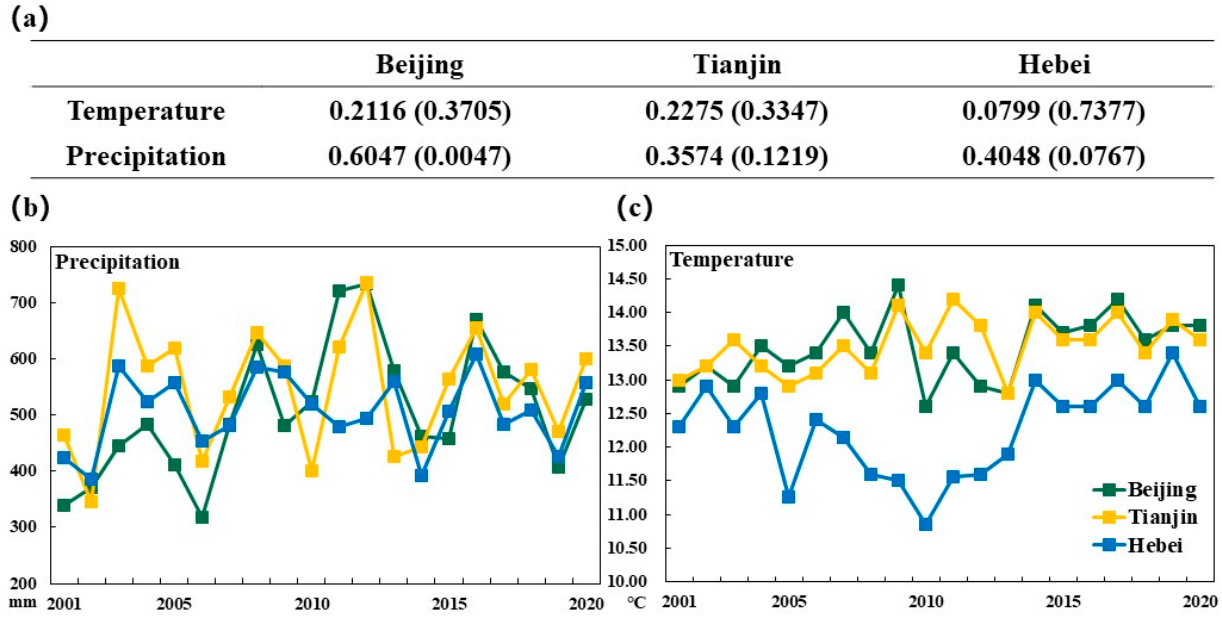
Figure 9. ( a ) Pearson correlation coefficient and the significance probability between climate factors and NPP; ( b ) regional annual temperature change trend; and ( c ) regional annual precipitation change trend.